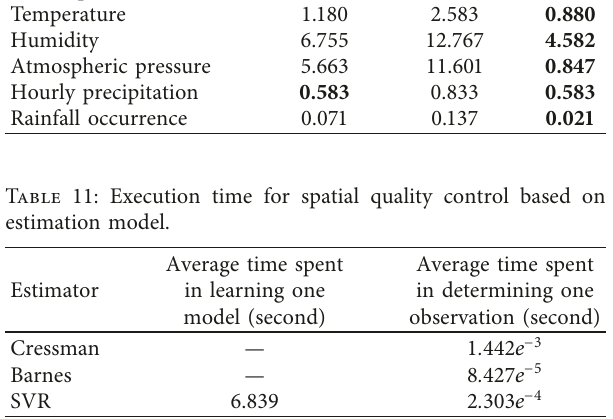
Figure 9: Time spent on determining one value depending on the size of the training